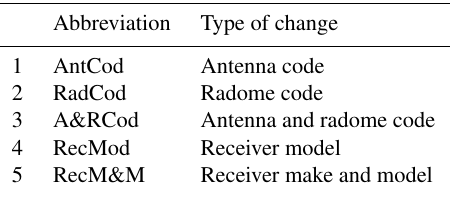
Table A2. Types of changes in GPS